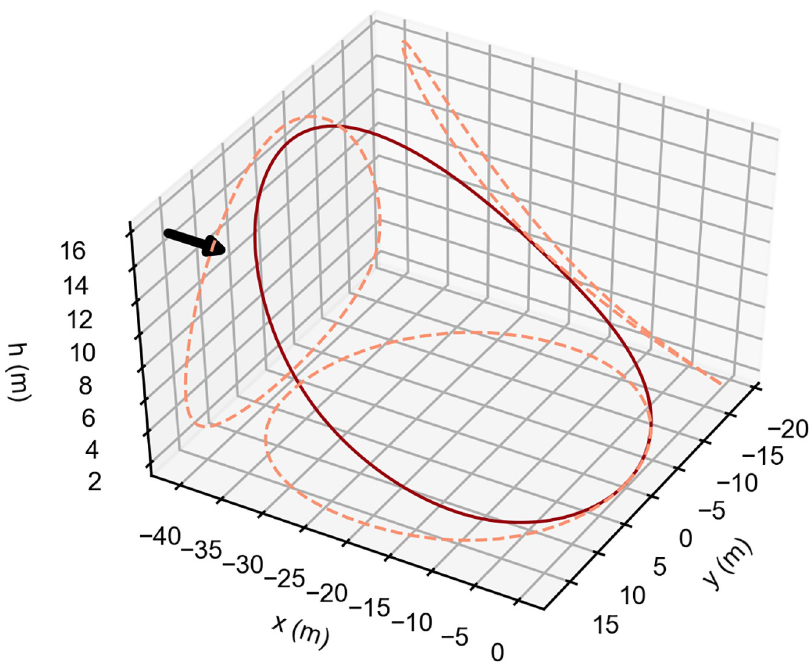
Fig 8. Rayleigh cycle optimal trajectory. Optimal single-loop, energy-neutral trajectory that minimizes the wind strength required in a step wind profile. Arrow indicates the wind direction. The dashed lines represent the trajectory projections on each of the three coordinates planes. The vehicle travels in the clockwise